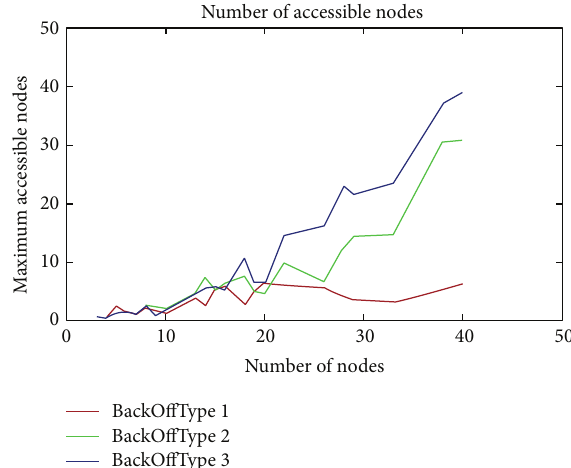
Figure 11: Maximum accessible nodes as a function of the number of nodes.